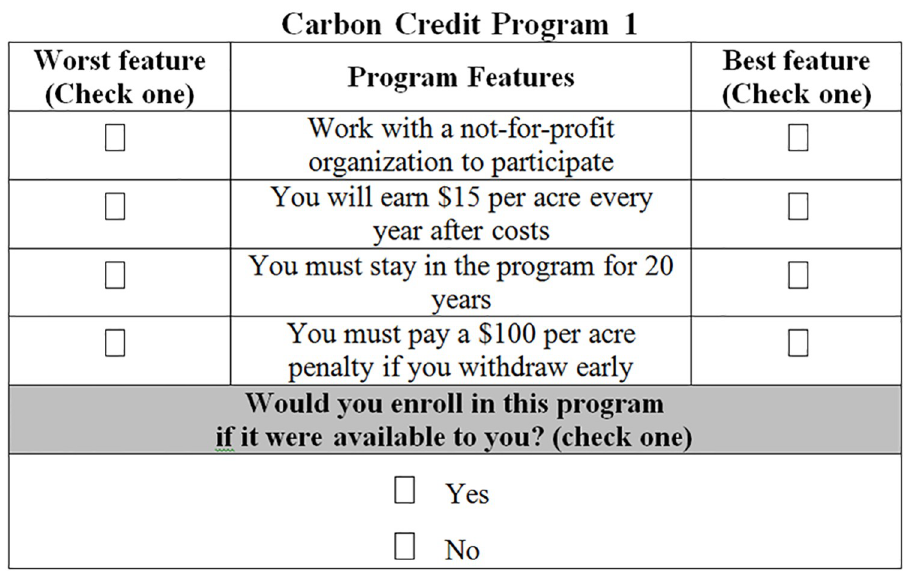
Fig 1. Choice scenario presented to respondents in mail